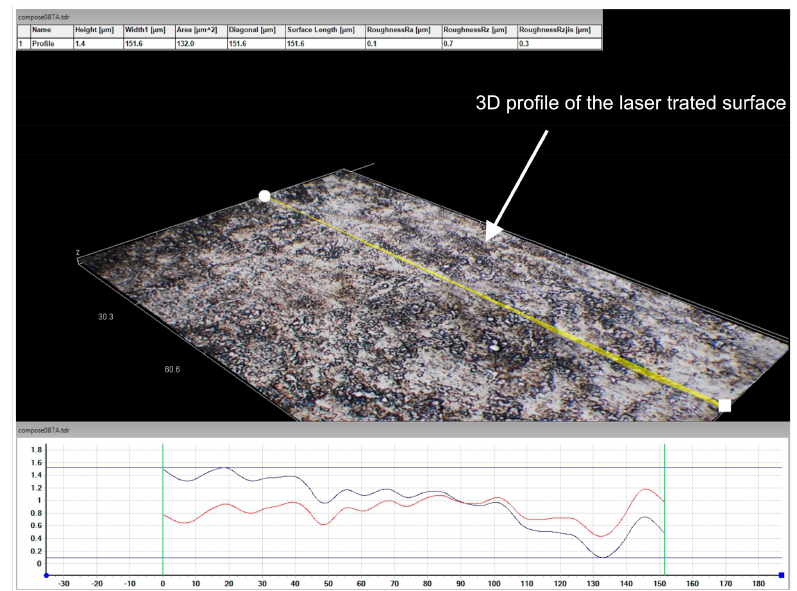
Figure 3. Three-dimensional scanning and profile measurement of the surface after the laser process- ing (Hyrox 3D digital microscope).